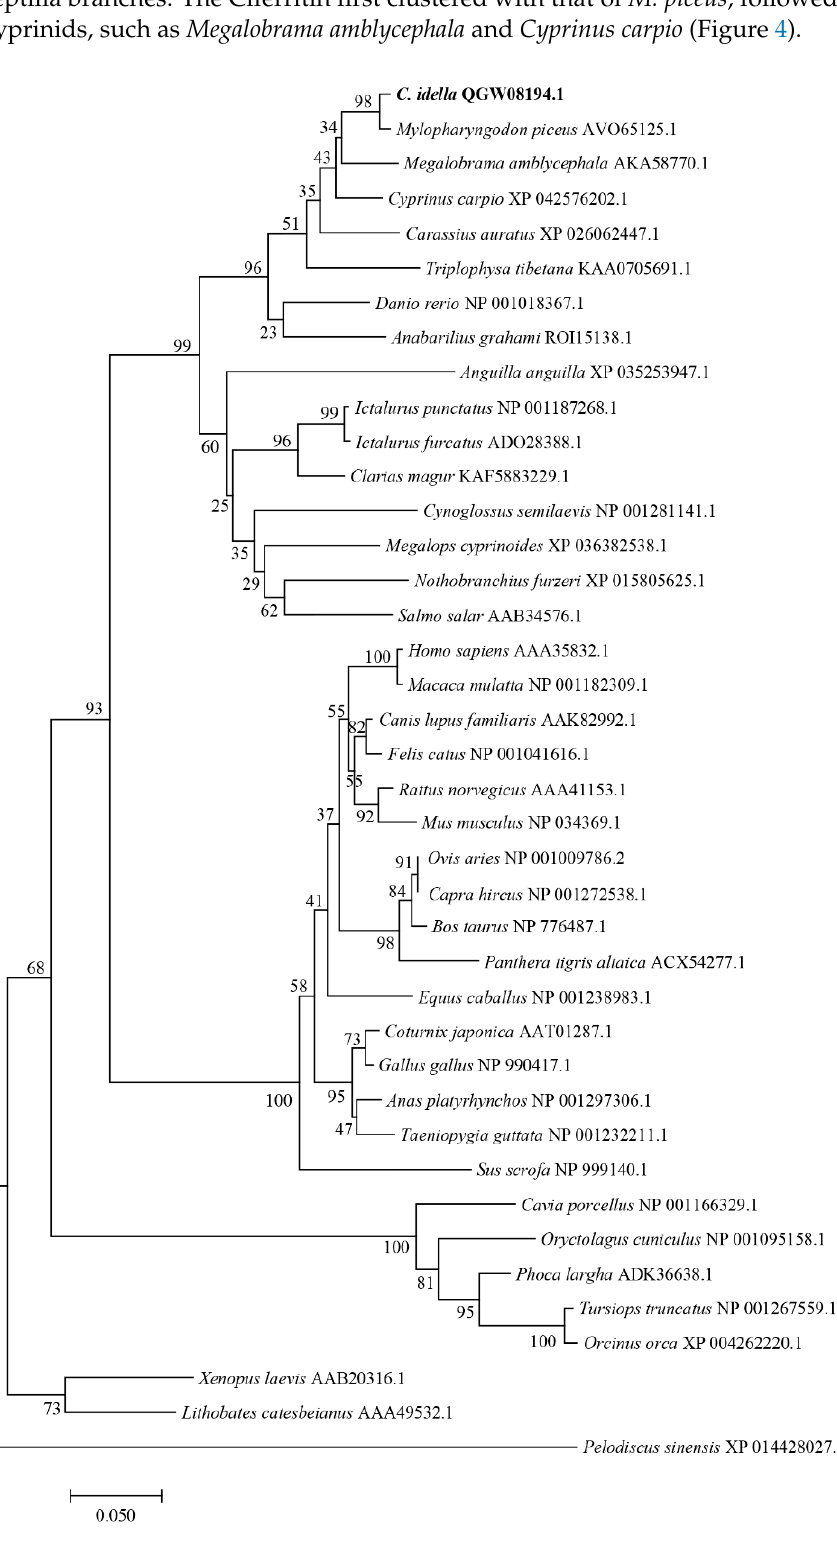
The expression levels of Ciferritin in response to GCRV infection and PBS treatment were detected. For the spleen, GCRV infection induced significantly higher Ciferritin ex- pression levels at 12 and 168 h than those in the PBS injection group (Figure 5A). In the kidney, Ciferritin expression levels were significantly higher in the GCRV infection groups at 6, 12, and 24 h than those in the PBS injection group ( p < 0.05) (Figure 5B).